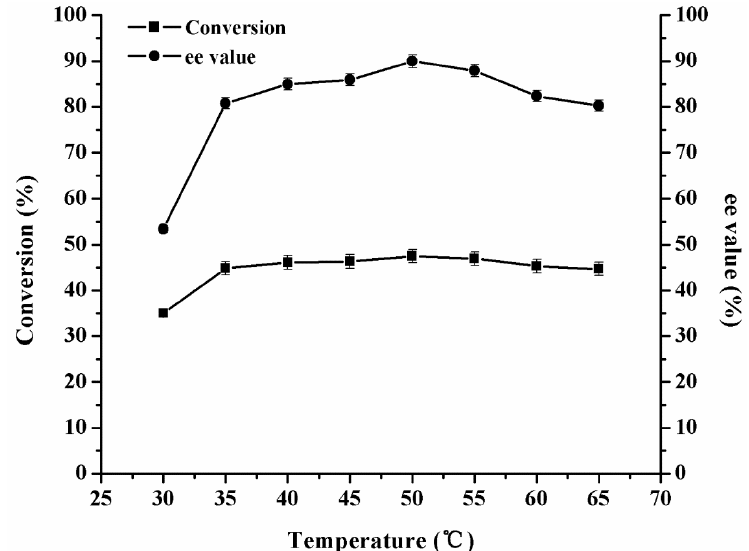
Figure 7. Temperature curve of resolution ( R , S )-1-phenylethanol using 0.02 g immobilized BCL as catalyst for 1 h.